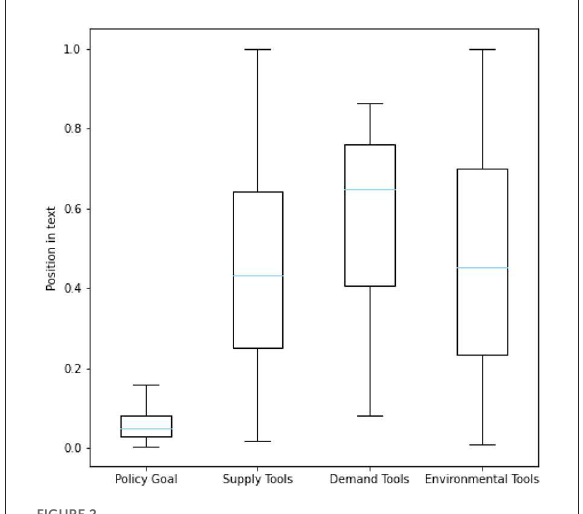
FIGURE2 The position of several policy elements.